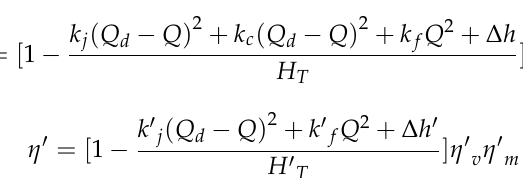
Figure 11. Hydraulic loss of the pump in: ( a ) shaft passage section; ( b ) diffusion straight tube passage; ( c ) entire passage; ( d ) sum of entire passage and inlet impact